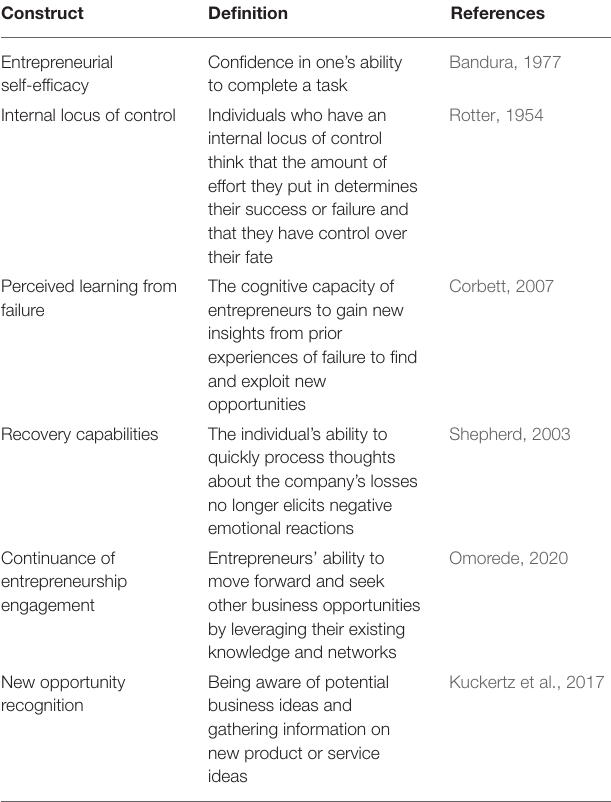
TABLE 1 | Operational